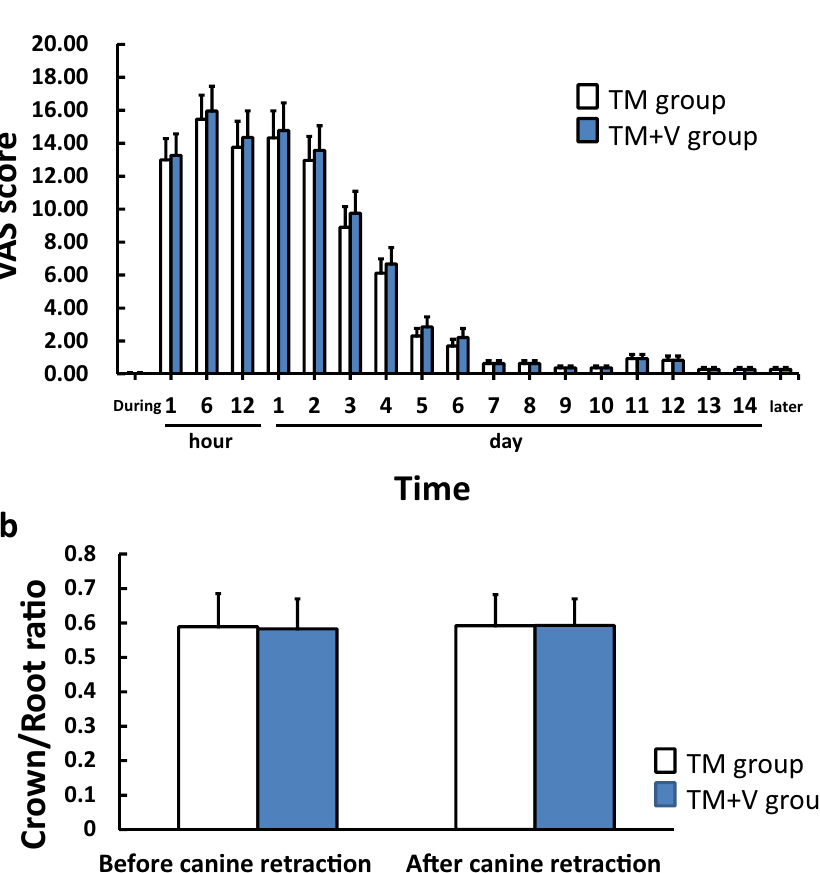
Figure 5. Evaluation of pain and root resorption. (a) VAS score. The horizontal axis indicated the period during and after the vibration, and the vertical axis indicated the VAS score (maximum value: 100). The VAS score increased from 1 h after the vibration and reached a maximum value at 6 h, after which VAS score decreased in the TM and TM + V groups. The mean VAS score did not exceed 1 mm after the 7th day. No significant difference was observed between the TM and TM + V groups at all time points. (b) Changes in crown root ratio before and after canine